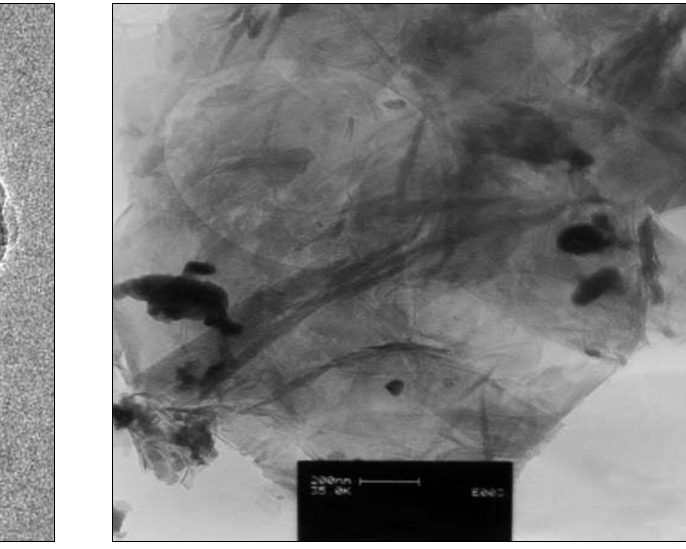
Fig. 5. TEM micrograph of GO (left) and GO-9-AA